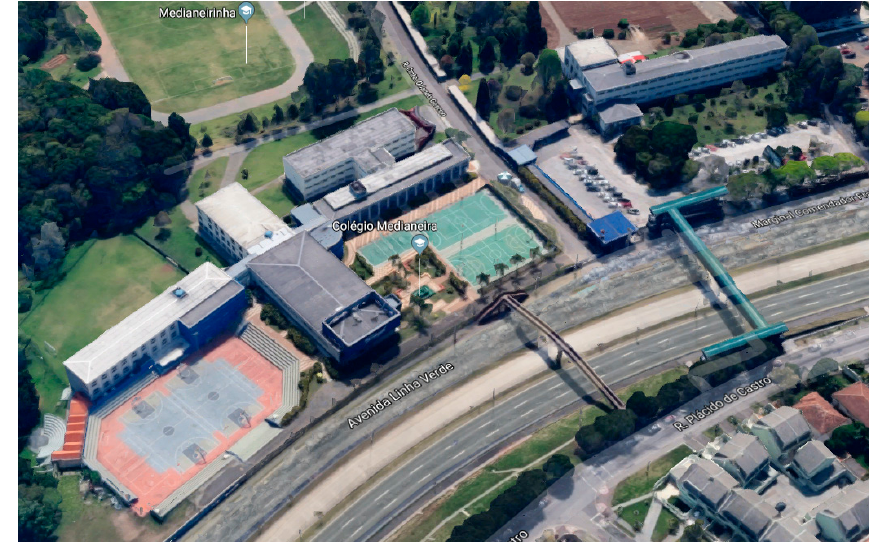
Figure 4. Medianeira School and white line demarcating the noise barrier.